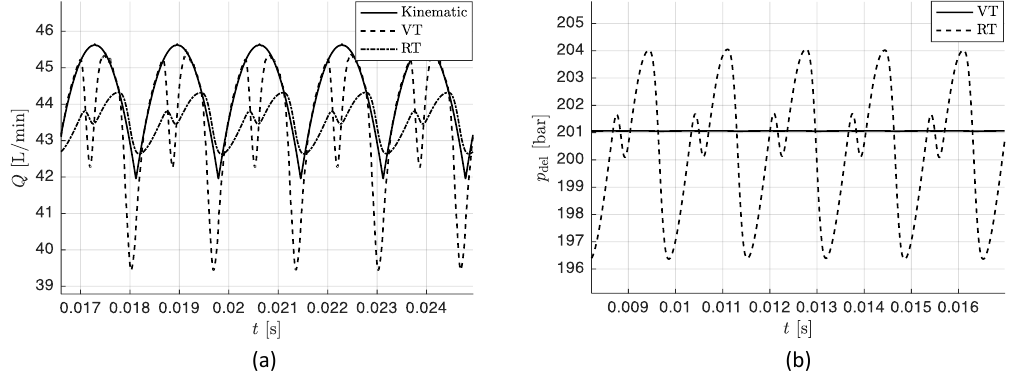
Figure 3. Comparison of ( a ) the flow ripple and ( b ) the pressure ripple for the reference pump working at 2000 RPM, 200 bar operating condition at VT and RT